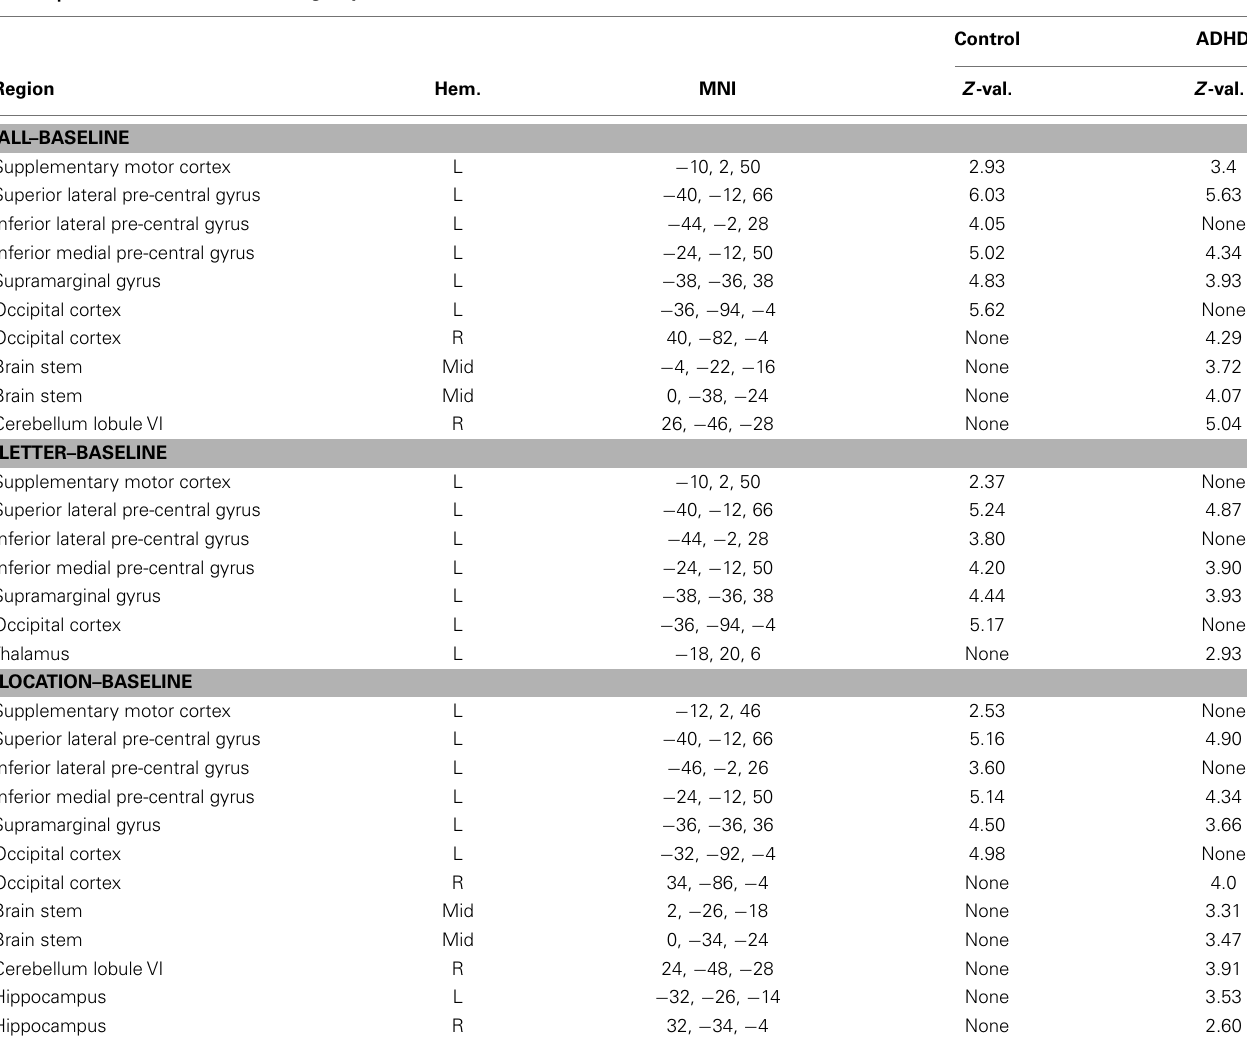
Table 3 | Condition–baseline: within-group effects